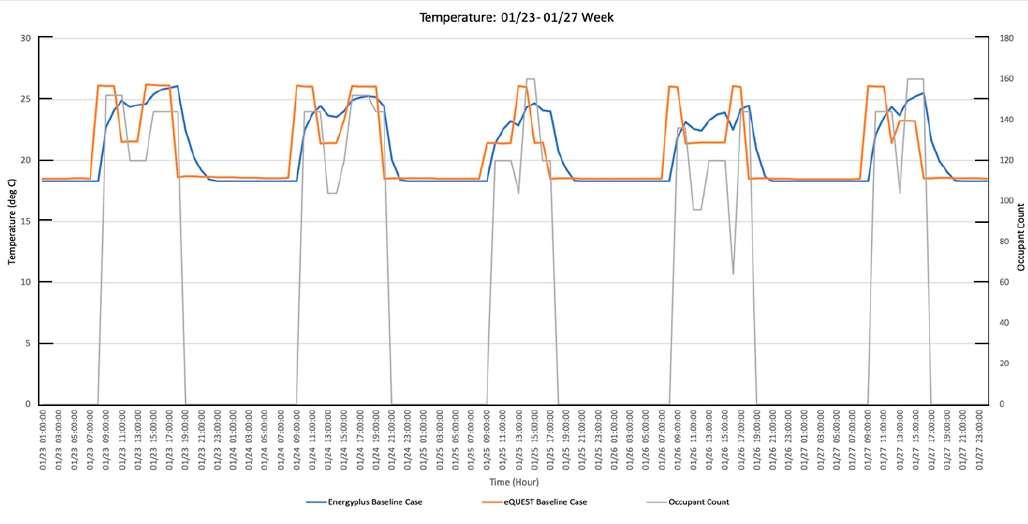
Figure 5. Simulated annual temperature profile from eQUEST and EnergyPlus showing overheating.